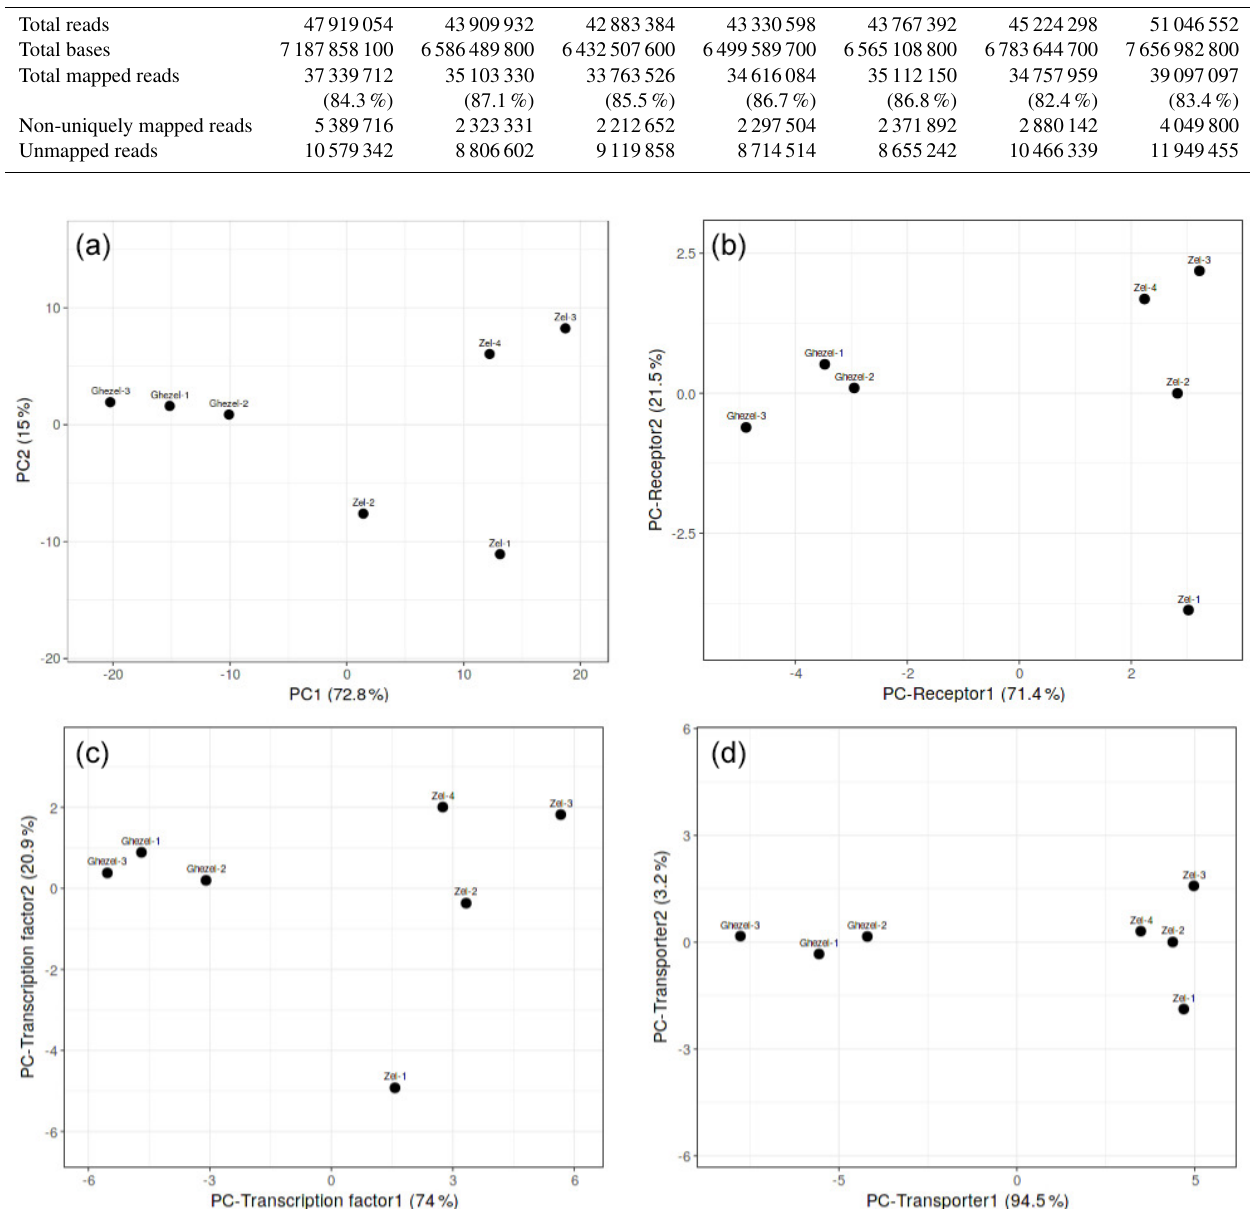
Table 1. Summary of RNA-seq data and mapping statistics of adipose samples of Zel (thin-tailed) and Ghezel (fat-tailed) sheep breeds. Samples